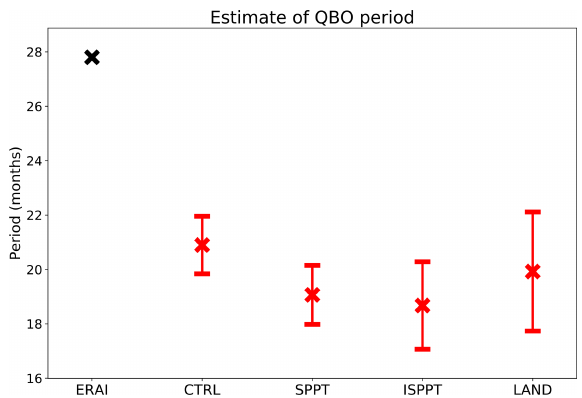
Figure 10. Estimates of the QBO period, as measured using equa- torial zonal winds at 50hPa. The red crosses show the mean across the five estimates (computed from the five ensemble members) for each scheme, and the error bars capture twice the standard error of this mean estimate. The ERA-Interim reanalysis product is shown in black for